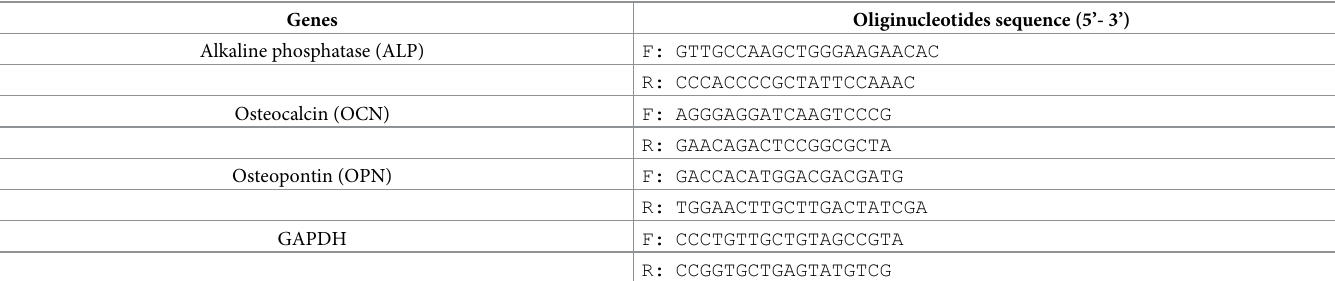
Table 1. Primer pair sequences used in real-time RT-PCR